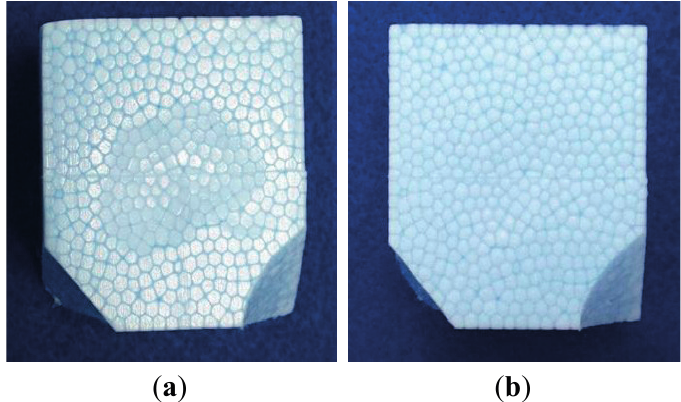
Figure 1. The shape memory effect (SME) in styrofoam. ( a ) after finger impression at room temperature; ( b ) after heating in boiling